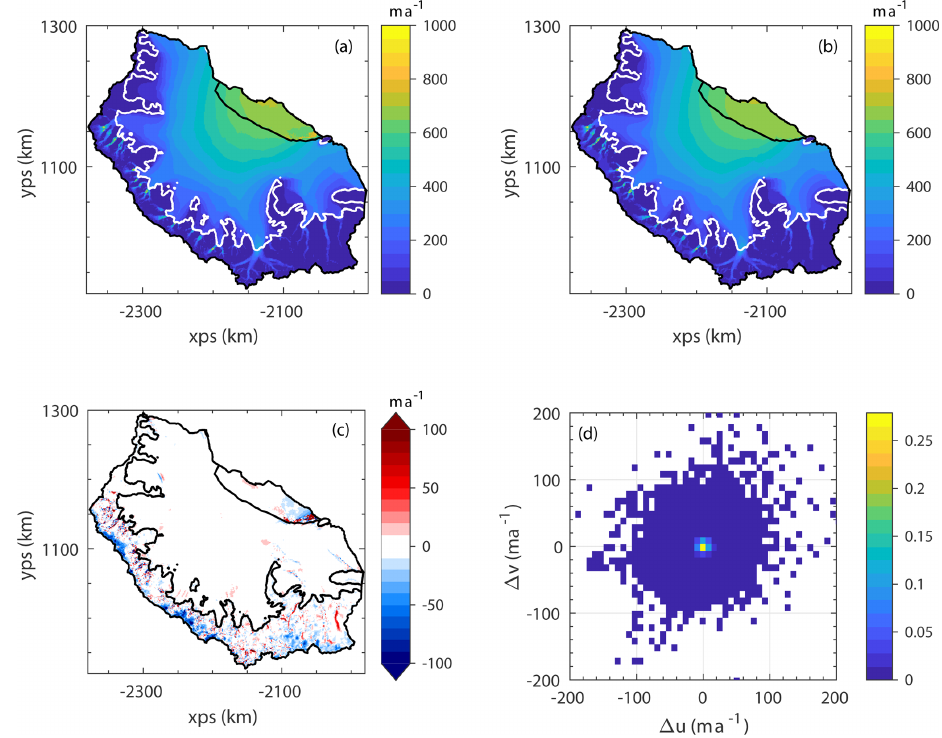
Figure 2. Observed ice speed (a) (from the MEaSUREs InSAR-based Antarctic ice velocity map) and modelled ice speed (b) following the initialisation procedure. Panel (c) shows the difference between the observed and modelled ice speed (obs − mod) and (d) is a normalised, bivariate histogram of the differences between the x and y components of the observed and modelled ice velocities at each node in the computational